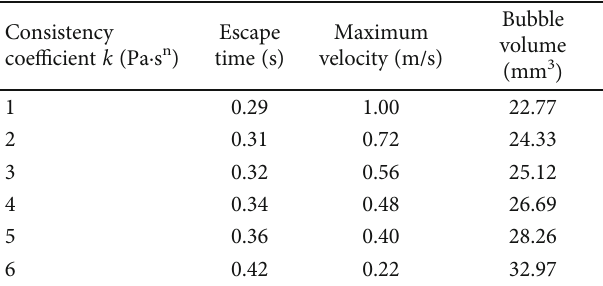
Table 4: Bubble escape time, maximum velocity, and bubble volume for di ff erent consistency coe ffi